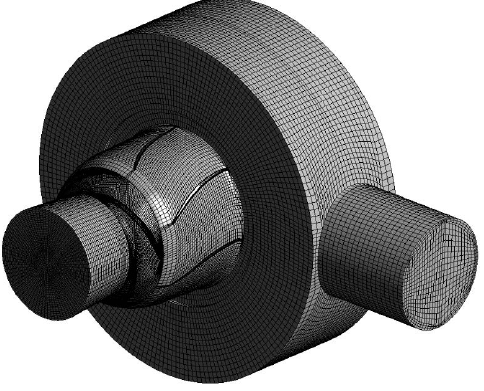
Figure 6. Mesh of the computational area. Table 1. Boundary conditions.